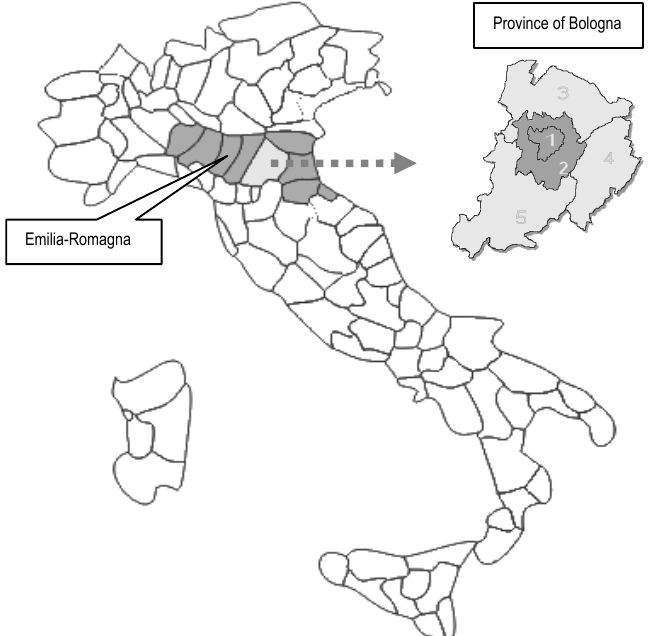
Figure 1 – Italy, Emilia-Romagna and the Province of Bologna (divided into 5 areas according to geographical and touristic